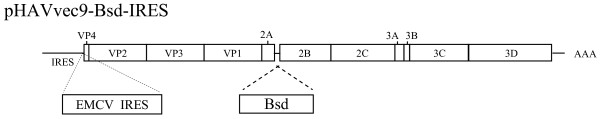
Schematic representation of the HAV construct containing the EMCV IRES at the 5'NTR and the Bsd resistance gene at the 2A-2B junction. The EMCV IRES was inserted into the HAV 5'NTR in pHAVvec9-Bsd. The construct containing both the EMCV IRES at the 5'NTR and the Bsd resistance gene at the 2A-2B junction was termed pHAVvec9-Bsd-IRES.